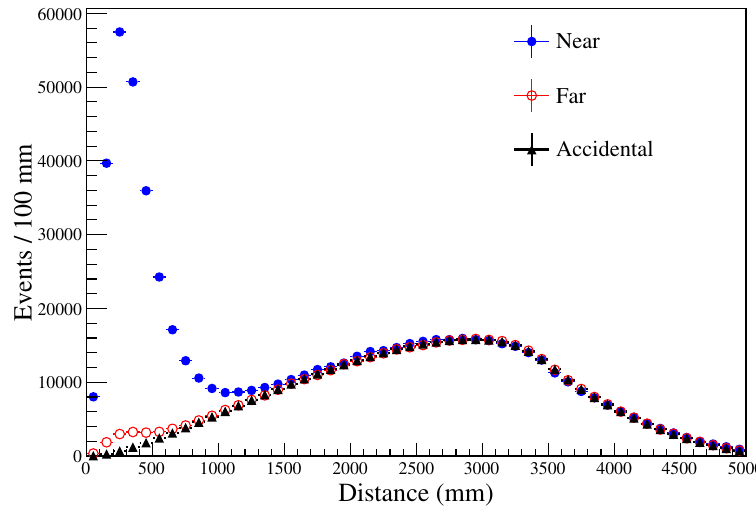
Figure 8 . Distance between prompt and delayed candidates. The far data (red) is normalized to the near data (blue) at (cid:24) 3000 mm. A requirement of (cid:1) R < 450 mm is e(cid:14)cient to remove most of the accidental